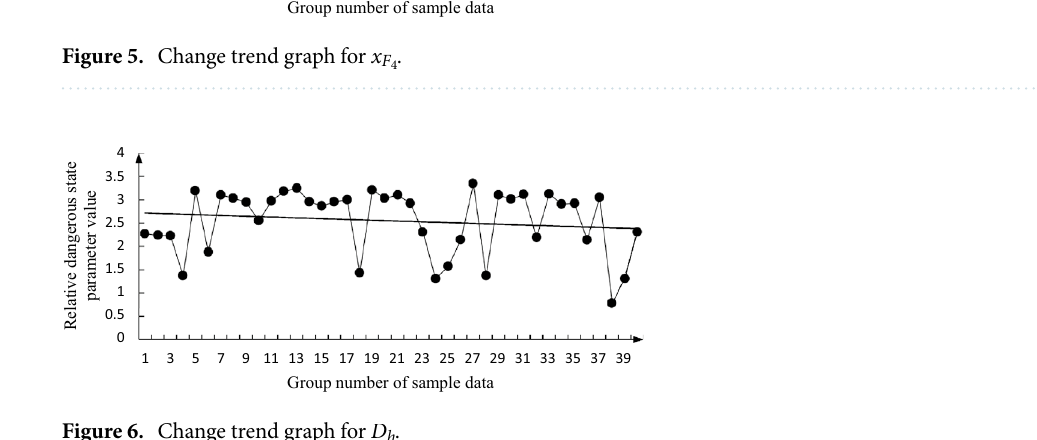
Figure 6. Change trend graph for D h